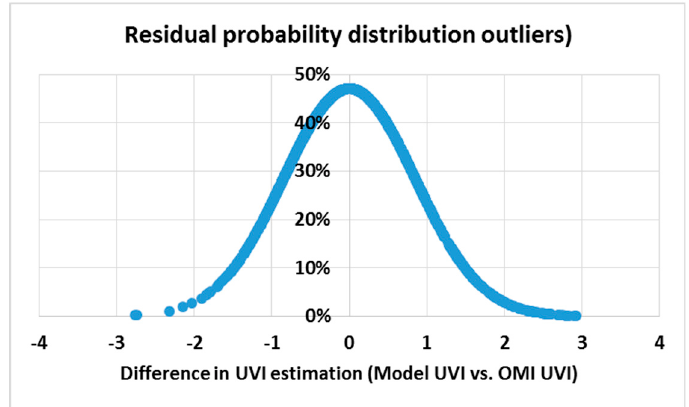
Figure 9. Probability distribution function of the residuals (difference in model UVI values versus the satellite UVI data).